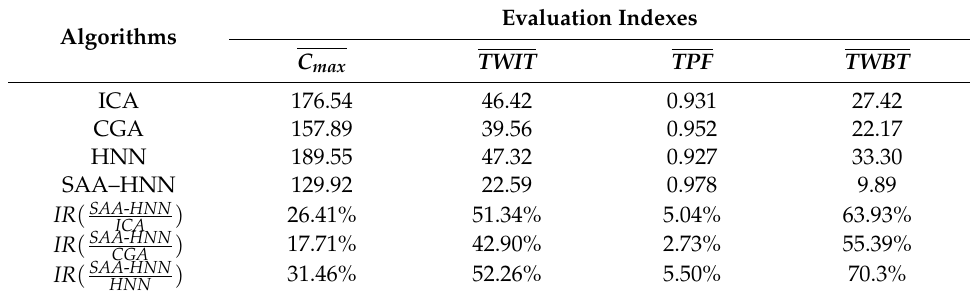
Table 5. Comparison of the evaluation indexes of four algorithms’ scheduling results (small-scale data).